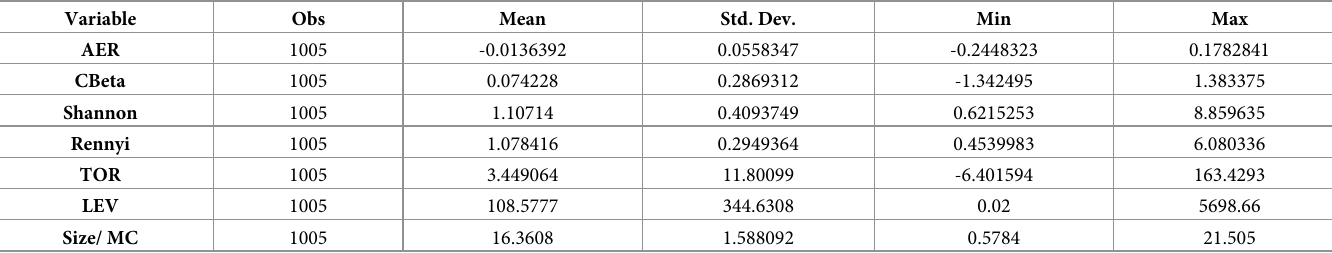
Table 2. Summary statistics.